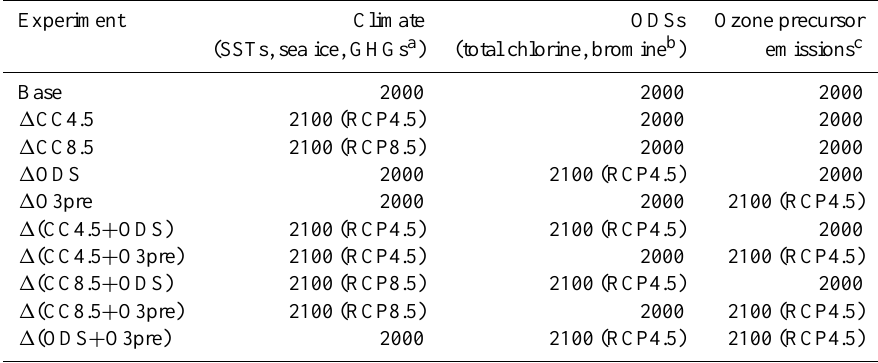
Table 1. List of model